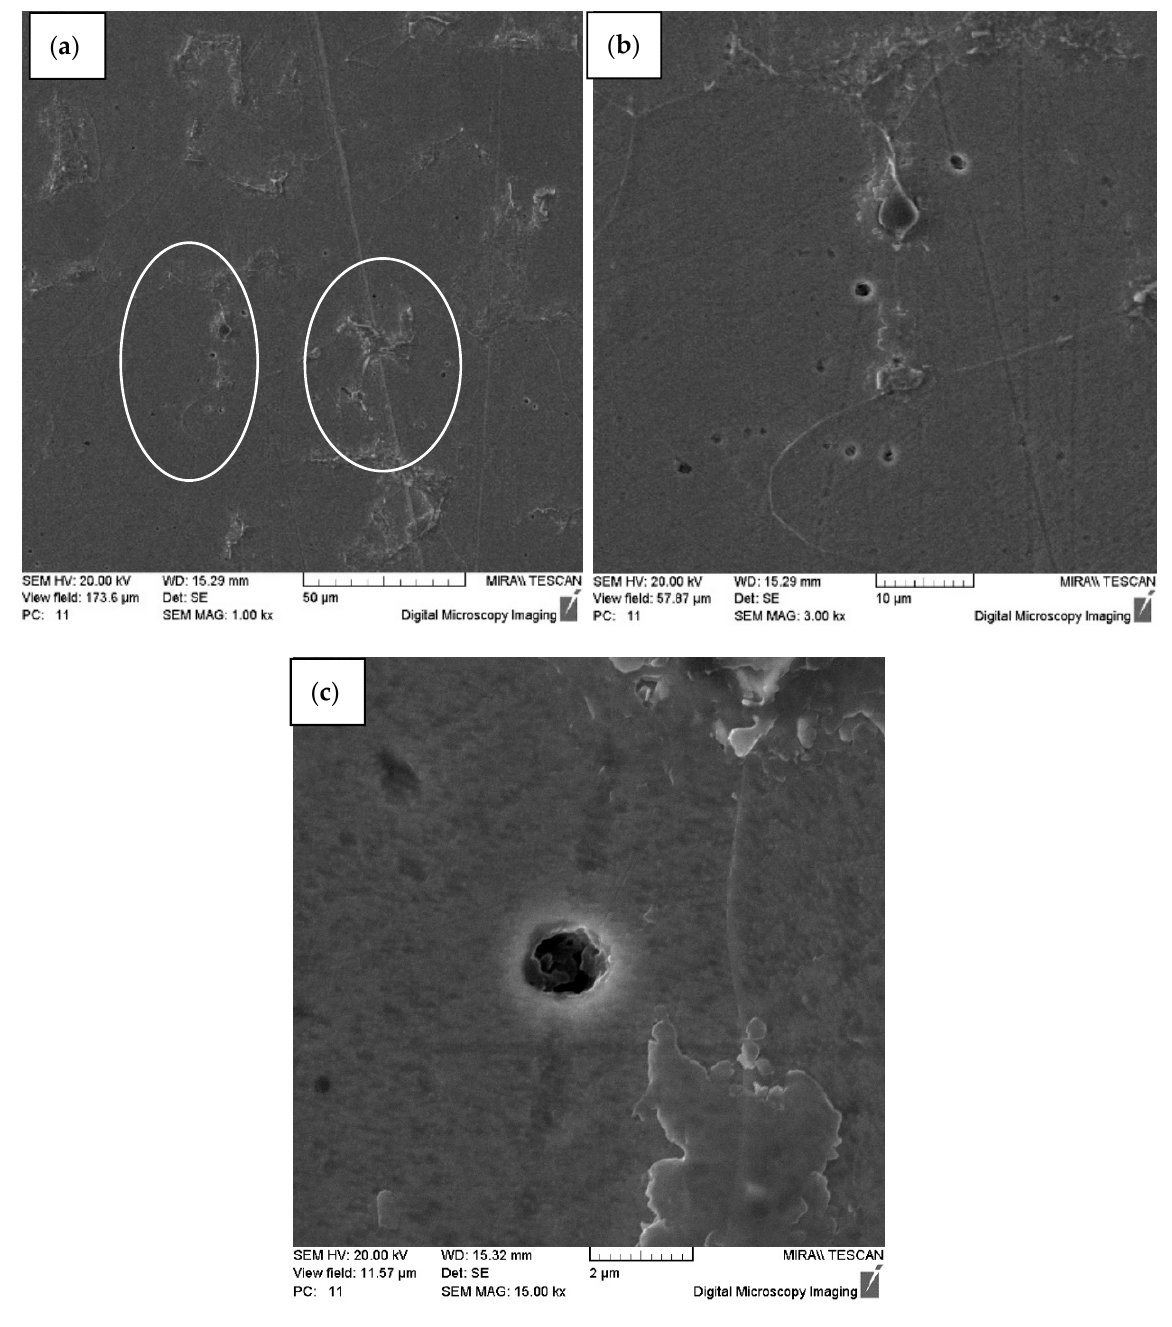
Figure 4. The structure of steel St3 after the dynamic alloying in the SDP mode. Transverse direction of the section (across the direction of particle stream): ( a ) Microstructure of steel St3 after the dynamic alloying in the SDP mode with channels (in circles); ( b , c ) channel elements (fibers).